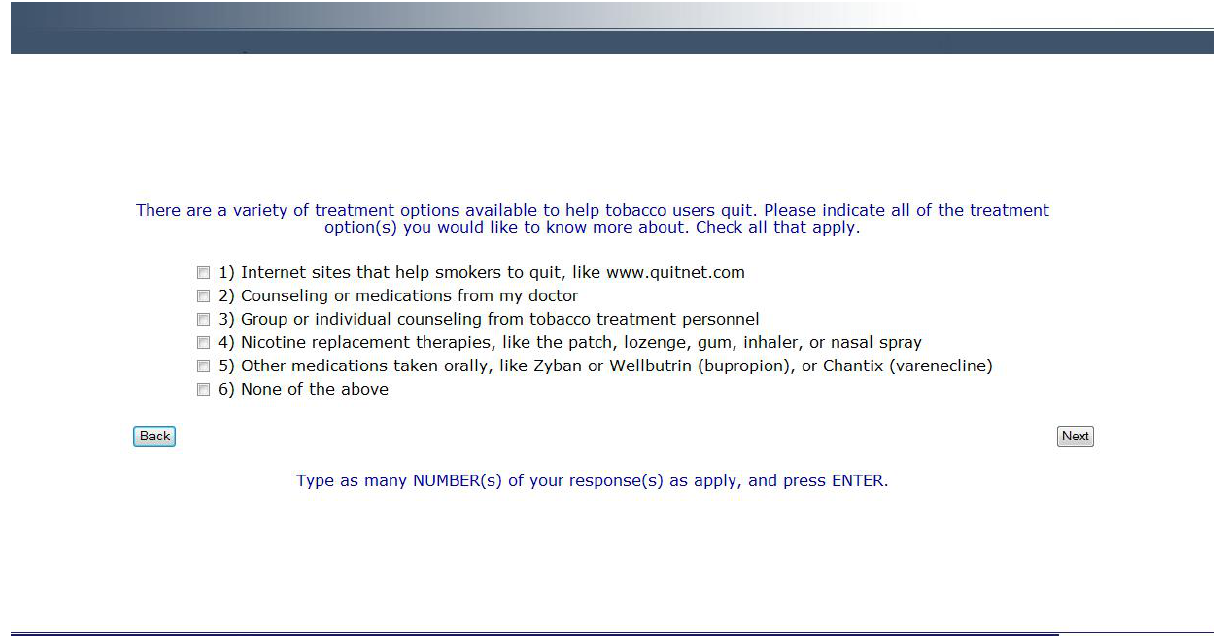
Figure 5. Screenshot from the CABIT program showing treatment options for